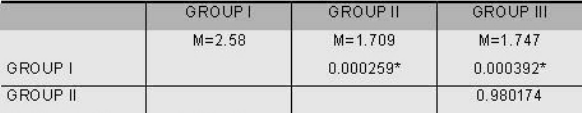
TABLE 3- Tukey test